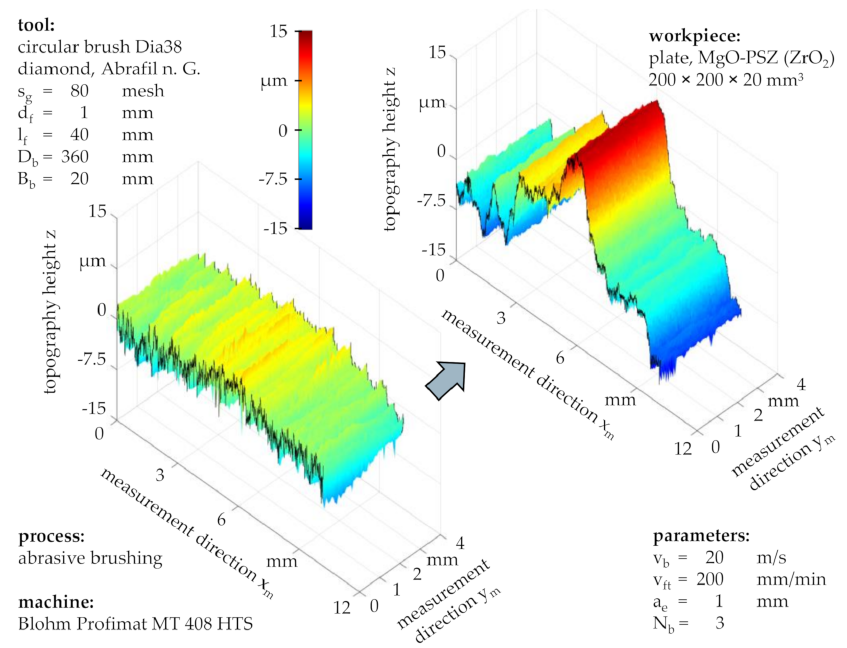
Figure 8. Topography of ZrO 2 , brushed with a grain size of s g = 80